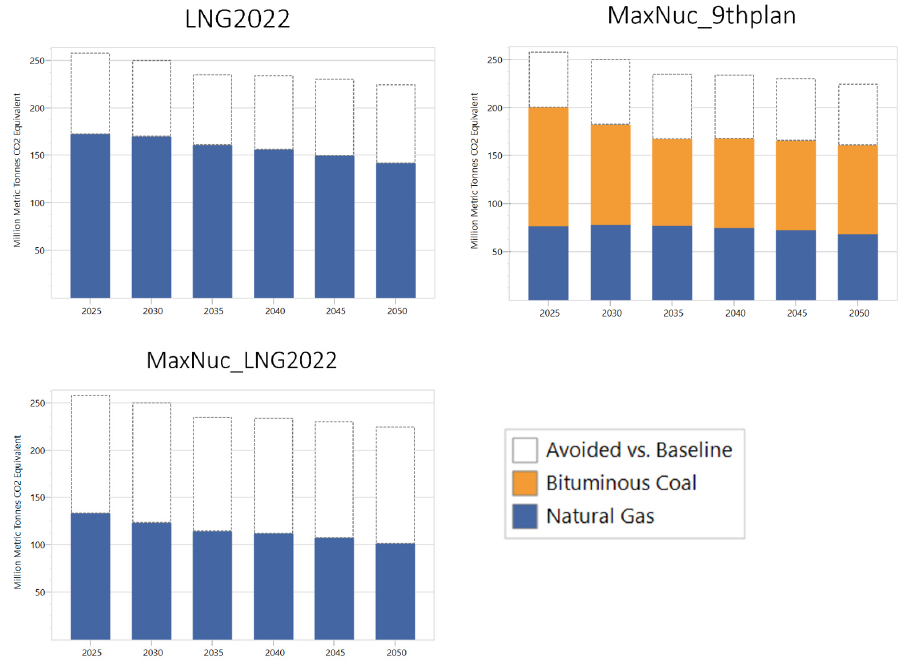
Figure 9. Energy sector million tons of CO 2 equivalent (MTCO 2 e) emissions, and avoided emissions compared to baseline.